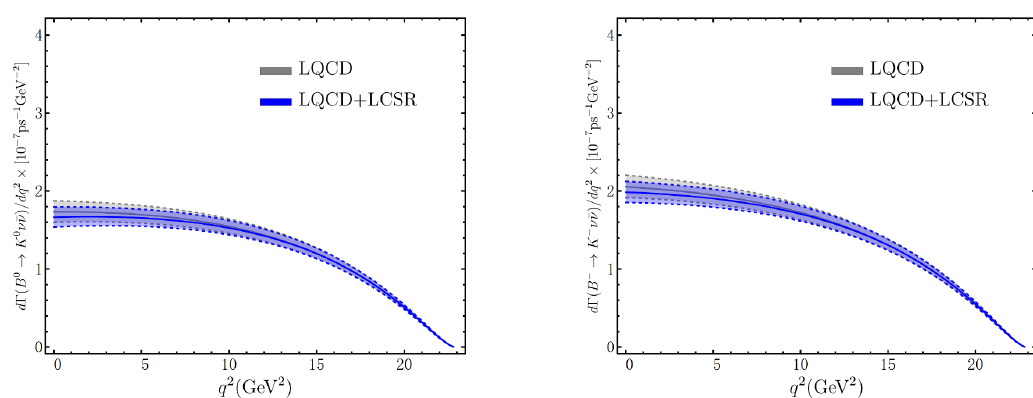
Figure 15 . Theory predictions for the differential decay distributions of B 0 → K 0 ν ‘ ¯ ν ‘ (left panel) and B − → K − ν ¯ ν (right panel) by applying the form factors determined from the two distinct ‘ ‘ scenarios of the BCL z -series expansion fitting